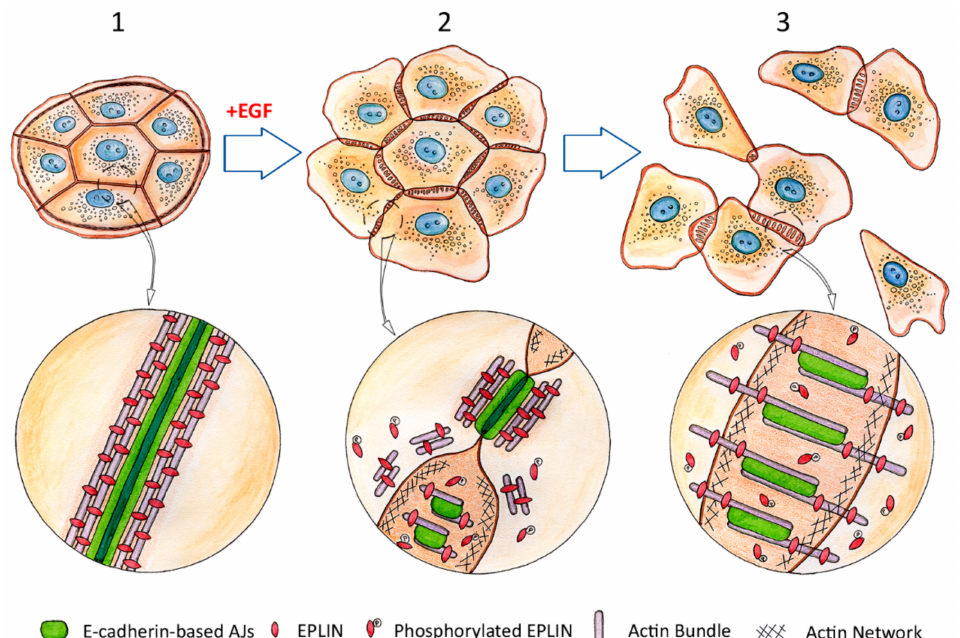
Figure 4. Dissolution of the circumferential actin bundle, degradation of EPLIN and rearrangement of E-cadherin-based adherens junctions (AJs) during the early stages of epithelial-mesenchymal transition (EMT). Adapted from Zhitnyak et al., Cells 2020, 9, 578 [150]. Top row: progression of EMT induced by Epidermal Growth Factor (EGF). 1 —epithelial cells before treatment with EGF. An island of non-motile cells tightly connected by linear AJs. Circled area in higher magnification below: a stable linear AJ between epithelial cells, associated with a robust circumferential actin bundle. EPLIN supports the bundle integrity by cross-linking actin filaments. 2 —early stages of EGF-induced EMT (5–10 min). Protrusive activity increases at the cell edges and protrusions begin to form at the cell-cell boundaries. Contact paralysis at the cell-cell boundaries disappears. Linear AJs are partially disassembled and replaced by punctate AJs. Circled area in higher magnification below: Dissolution of the circumferential actin bundle and reorganization of linear AJs. Part of the AJ still maintains its original linear configuration and is associated with the remnants of the circumferential actin bundle. Phosphorylation of EPLIN results in its detachment from the circumferential actin bundle which leads to disintegration of the bundle. Bottom part—formation of small punctate AJs associated with nascent straight actin bundles. 3 —later stages of EGF-induced EMT (15–60 min). Cells acquire migratory properties and detach from each other, breaking cell-cell adhesion. The new punctate AJs formed by migratory cells are dynamic and unstable. Circled area in higher magnification below: mature punctate AJs during later stages of EMT. The AJs are longer than in 2 and are associated with thicker straight actin bundles again fortified by